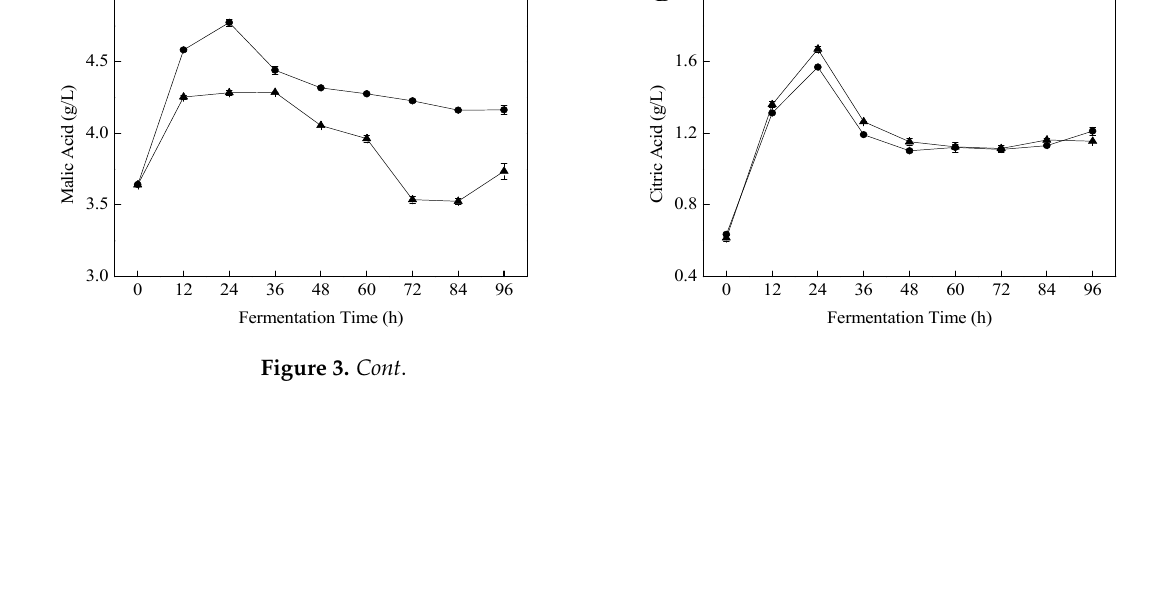
can provide a delightful sourness and act as a flavoring agent to create a smoother, more natural taste [27].